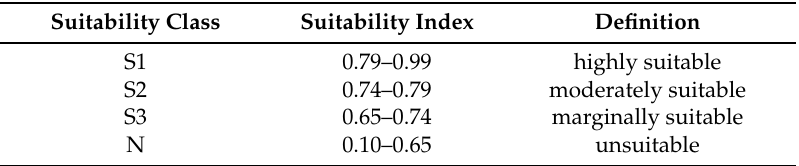
Table 4. Land suitability classes for the barely in the study area.